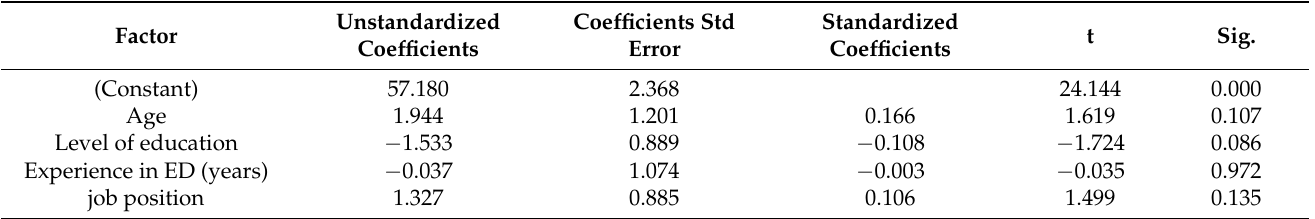
Table 5. Multiple linear regression of independent factors of nurses’ perceptions of quality of nurse– physician